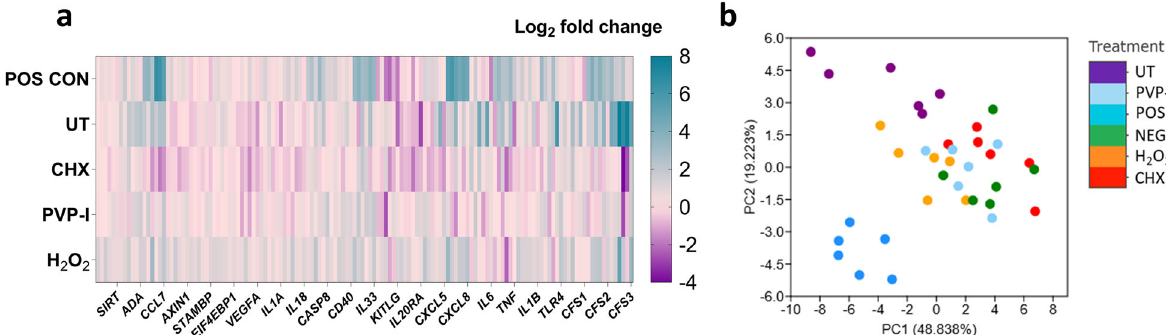
Fig. 4 Transcriptional pro fi ling of the RHE tissue following bio fi lm stimulation. Skin epidermis was exposed to treated and untreated bio fi lms for 24 h at 37°C, 5% CO 2 . Appropriate negative and positive controls were used. Following stimulation, RNA was extracted, cDNA synthesized, and gene expression was pro fi led using a custom array containing primers for different pro-in fl ammatory genes and upregulated proteins from the Olink technology (Fig. 5). Panel a depicts the Log 2 fold change in RHE tissue stimulated with PMA (POS CON), untreated bio fi lms (UT), CHX-treated, PVP-I-treated, or H 2 O 2 -treated bio fi lms, all relative to unstimulated negative controls. Data presented as a n = 6, encompassing three technical replicates from two independent experiments. Each column represents these 6 replicates. Panel b shows a principal component analysis plot showing distinct clustering of the transcriptional pro fi les in the tissue following stimulation. such as IL-8 and VEGFA, whereby higher protein levels were reduced the in fl ammatory response in the tissue to levels further con fi rmed using ELISA (Supplementary Fig 7a and b). comparable with unstimulated RHE. Similarly to the transcriptional response, PCA plots highlighted Using Olink technology and an “ in fl ammation ” panel of that PMA-stimulated RHE samples showed the greatest variance proteins, hierarchical clustering of the RHE protein responses to from the other samples at both PC1 (~48%) and PC2 (~28%) (Fig. untreated and treated bio fi lms highlighted key differences 5b). For the bio fi lm-stimulated tissue, the protein responses in the between the treatments and controls. Firstly, in all positive RHE exposed to untreated bio fi lms and bio fi lms treated with CHX controls, PMA-stimulated tissue gave rise to a unique protein clustered together, with similar protein levels for SIRT2, STAMBP, response, with elevated levels of CDCP1, TGF-alpha, MMP-1, IL-20, AXIN1, ADA, and 4E-BP1 (Fig. 5b). Comparable levels of the and CXCL1 (Fig. 5a) as well as classical pro-in fl ammatory markers